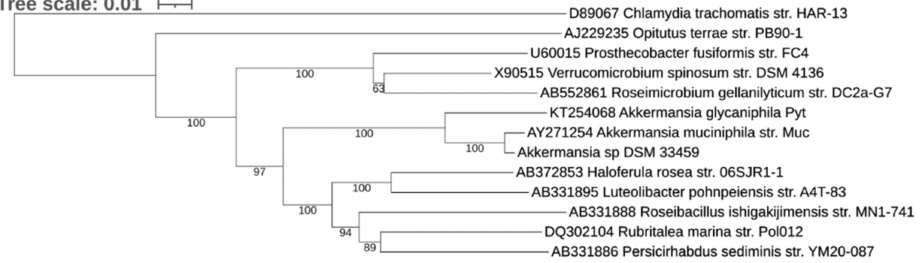
Figure 1. A phylogenetic tree consisting of Akkermansia sp. DSM 33459. The tree was reconstructed with the neighbor-joining method with 1000 bootstraps. Numbers represent bootstrap values. The legend bar indicates 5% sequence divergence. Chlamydia trachomatis was used as an outgroup. Table 1. Determination of Optimal Temperature for growth.